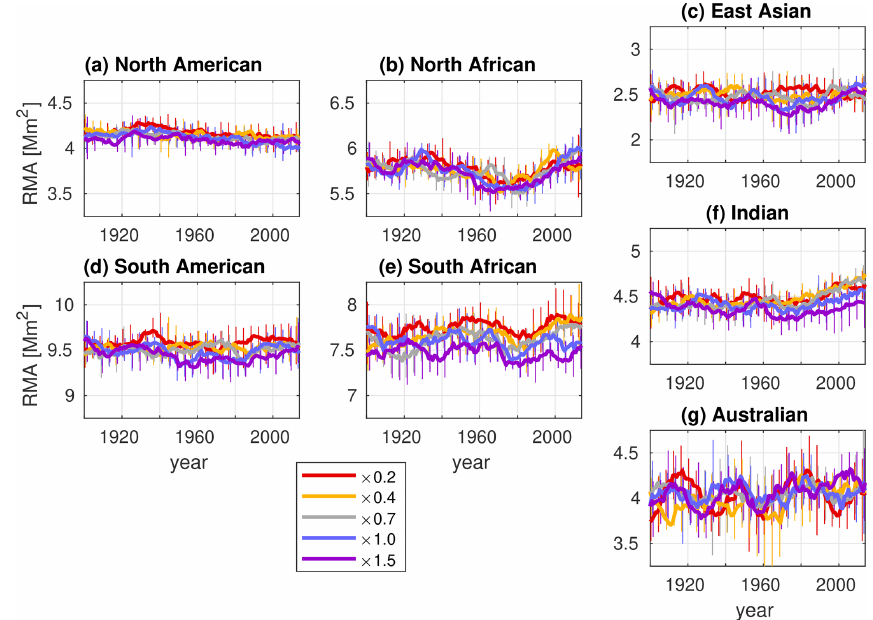
Figure 6. Time series of the regional monsoon area (RMA), following the style of Fig. 4. Here, the RMA is defined as the global monsoon area (GMA) that falls over land points within each monsoon region. Regions are as defined in Fig. 1d.